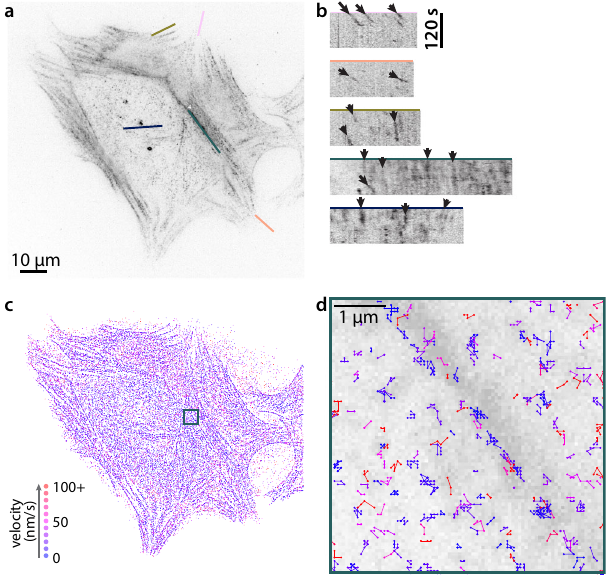
Fig. 1 SiR-Actin labeling reveals variation in F-actin velocities in fi broblasts. a An HFF labeled with 50 nM SiR-Actin. This labeling strategy was successfully repeated in live HFFs (5 experimental replicates), though SiR-Actin concentration was varied to achieve similar labeling densities (see Methods, Experimental Setup and Imaging). b Kymographs showing actin motion in the cell in a over 120 s, at the cell edge (pink and peach), closer to the cell body (olive), and in stress fi bers (teal and blue). c Single particle tracking for the same cell over the same 120 s interval. The fi rst point of each track is shown, color-coded by its apparent velocity. d Close up of the boxed region in c , showing all points of the tracks in and surrounding a stress fi ber. The tracks are overlaid over the mean intensity projection of the time series. Scale bar is 1 μ